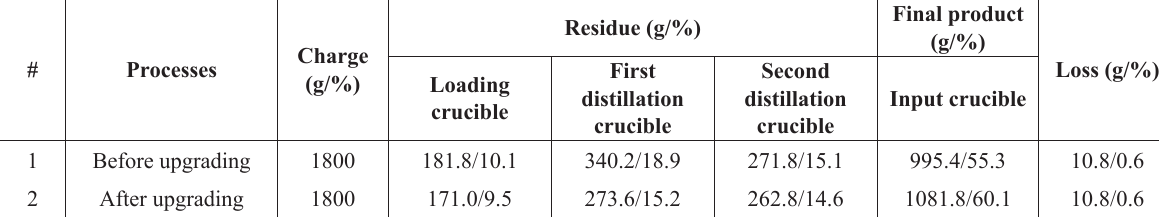
Table 3. Material balance for Te refinement process before and after equipment upgrading